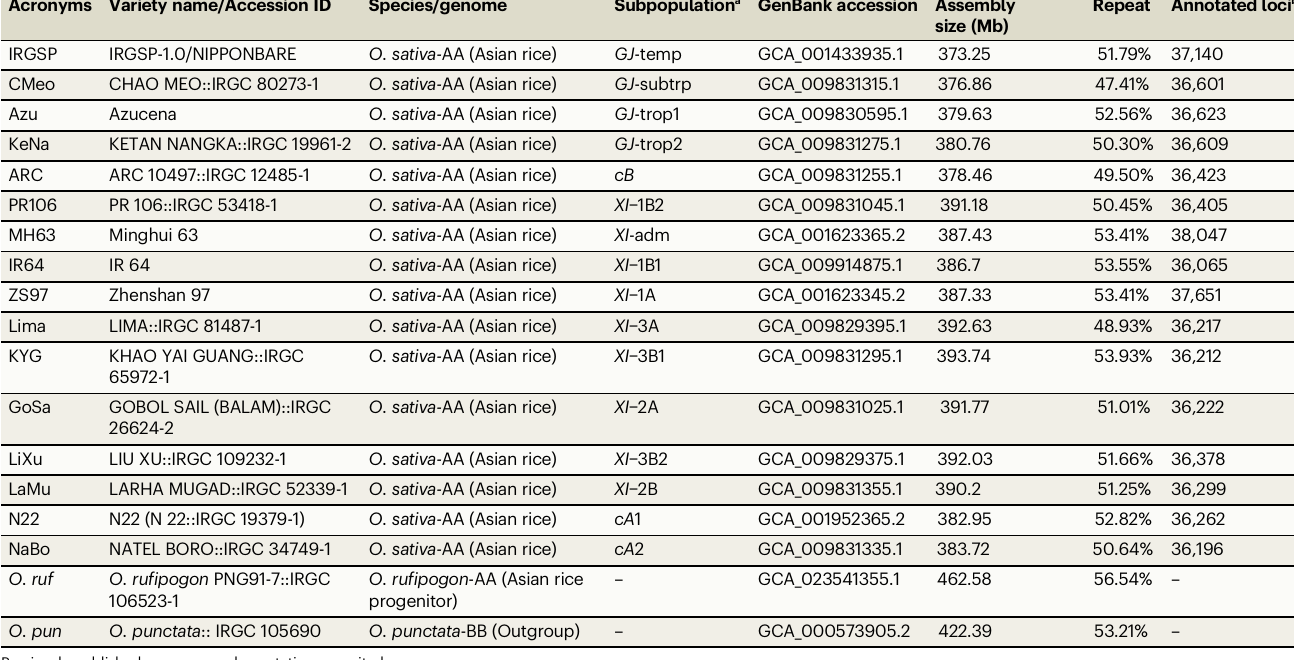
Table 1 | Assembly and annotation statistics of the 18-genome data package Acronyms Variety name/Accession